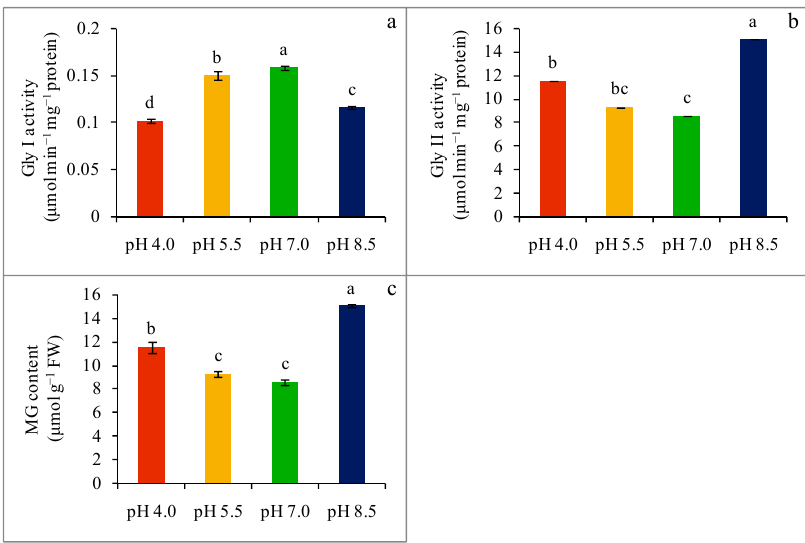
Figure 7. Activities of Gly I ( a ) and Gly II ( b ) and MG contents ( c ) of wheat leaves under different levels of pH. Mean ( ± SD) was computed from three replications of each treatment. Bars with dissimilar letters are significantly different at p ≤ 0.05 from Fisher’s LSD test.